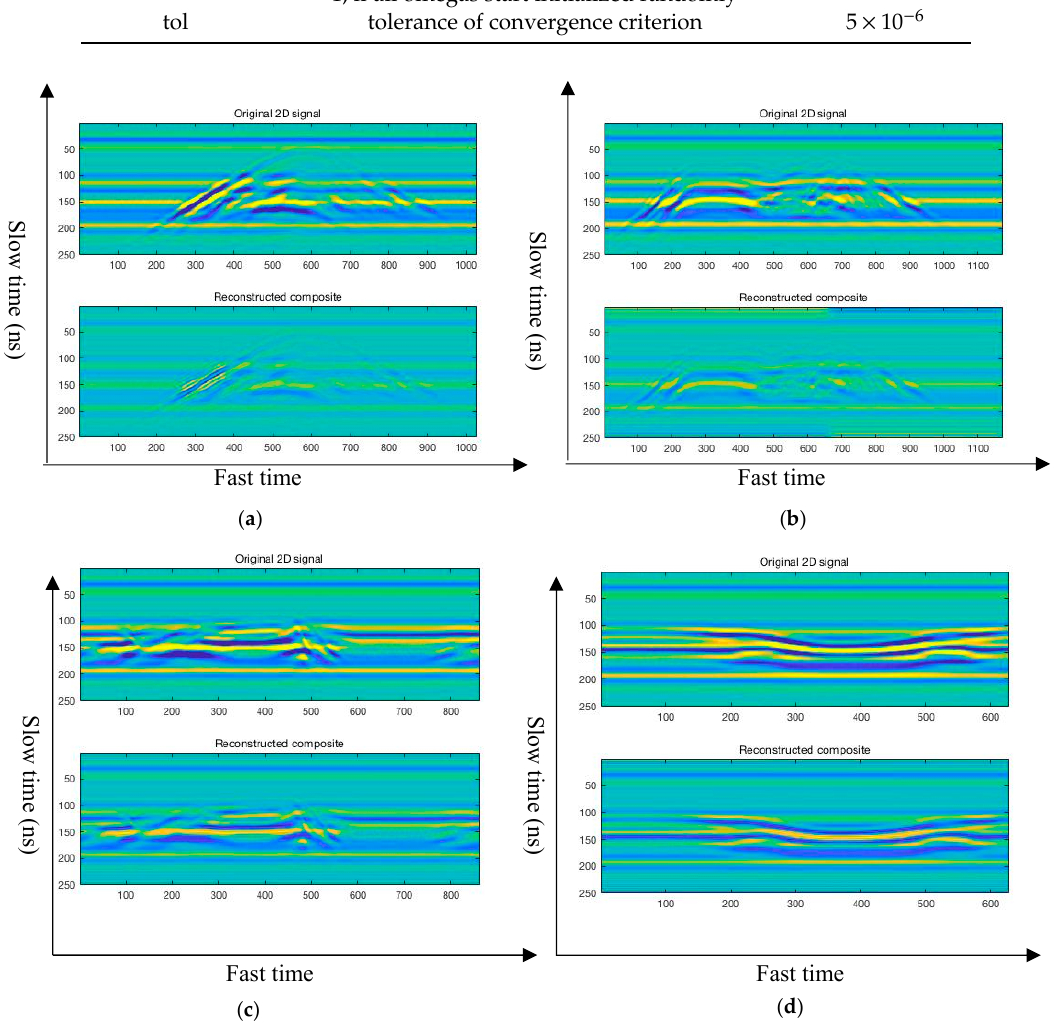
Figure 6. Four di ff erent types of human motion original 2D echo signals and reconstructed 2D echo signals. (The above figure shows the original human motion radar 2D echo signal, the blow figure shows the reconstructed 2D radar echo signal.) ( a ) Walk forward of human motion original 2D echo signal and reconstructed 2D echo signal; ( b ) fall forward of human motion original 2D echo signal and reconstructed 2D echo signal; ( c ) walk around of human motion original 2D echo signal and reconstructed 2D echo signal; and ( d ) jump forward of human motion original 2D echo signal and reconstructed 2D echo signal.